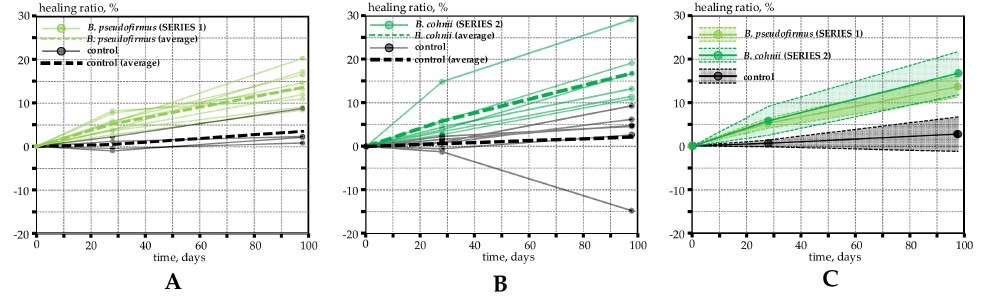
Figure 3. Variation in healing ratio over time: ( A ) results of test Series 1; ( B ) results of test Series 2; ( C ) comparison of healing ratio between test Series 1 and Series 2—continuous lines represent the average values of the calculated healing ratio, whereas shaded areas show 95% confidence